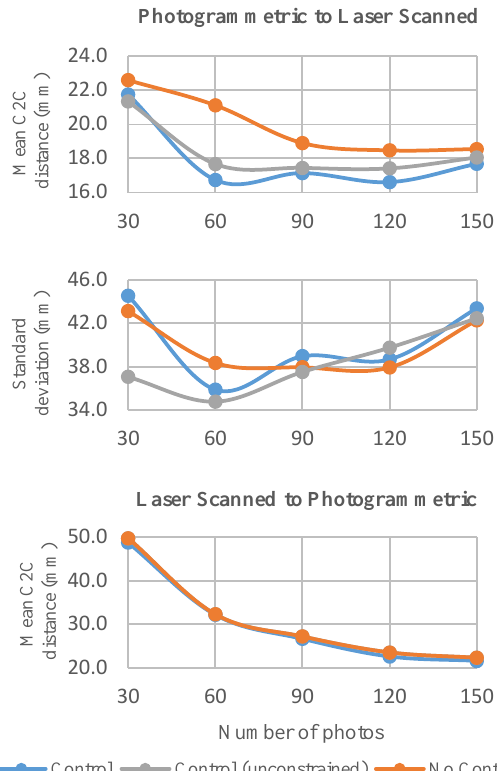
Figure 8. C2C distance testing of photosets with different numbers of